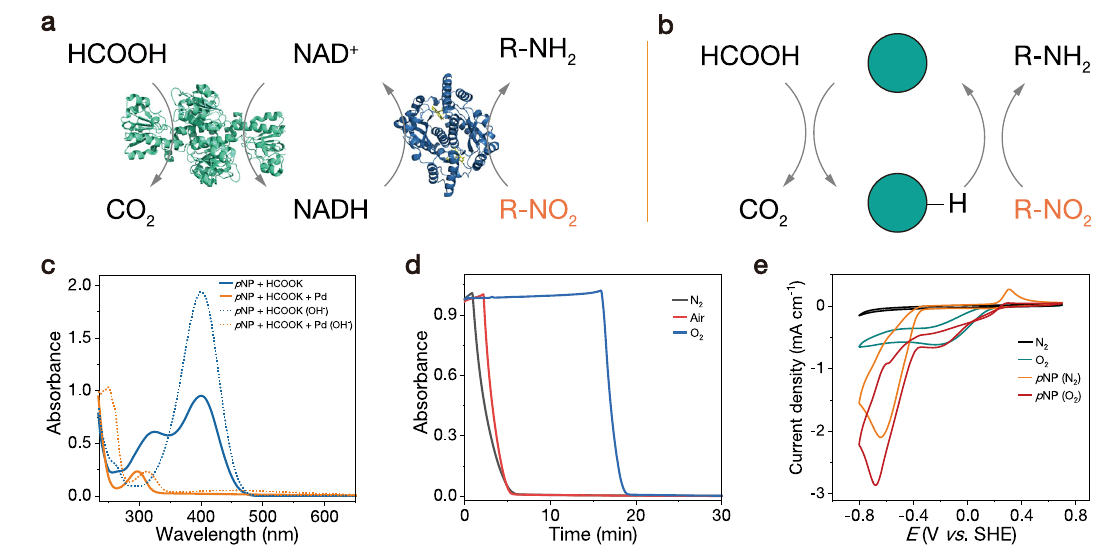
Fig. 5 Nitro compound reduction. a Schematic illustration of nitro reduction through the cascade reaction catalyzed by formate dehydrogenase coupled with nitroreductase. b Nitro compound reduction catalyzed by Pd NPs with formic acid as the electron donor. c UV – Vis absorption spectra of p NP (20 μ M) in different mixture solutions after reacting for 10 min. Dotted line: NaOH was added before UV – Vis absorption measurement. d UV – Vis absorption of p NP (20 μ M) at 400 nm versus time under different conditions. e Cyclic voltammograms of Pd NPs in the presence of p NP (10 mM), with a scan rate of 10 mV s − 1 . All experiments were conducted in PBS (50 mM, pH =